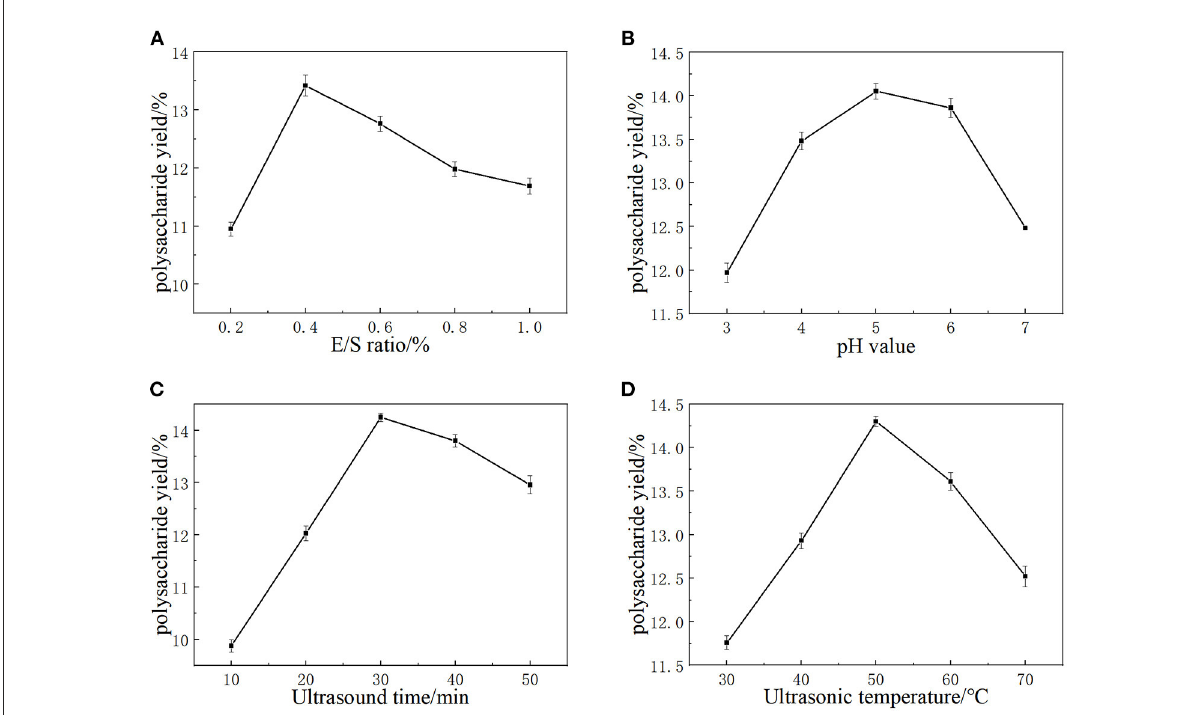
FIGURE1 The effects of E/S ratio (A) , extraction pH (B) , Ultrasound time (C) , and Ultrasonic temperature (D) on the yield of